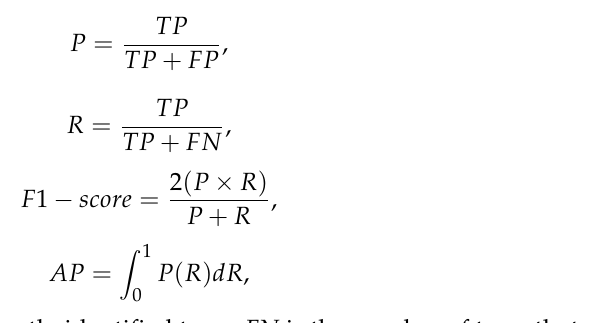
correctly identified trees and the number of ground-truth trees. The F1-score is the overall accuracy